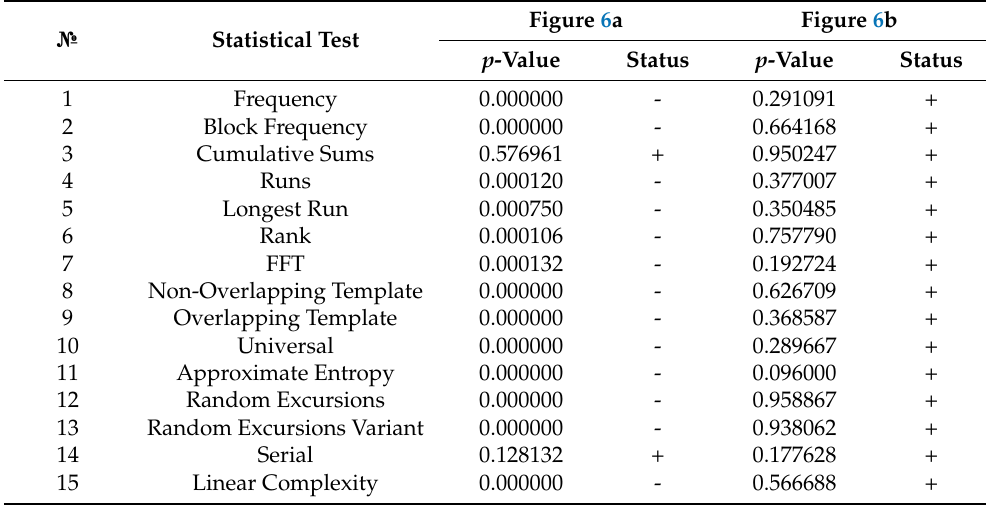
Figure 6. Statistical portrait of the MAFG output sequence: ( a ) with an odd value h = 9, ( b ) at an even value h = 10. Table 2. Results of testing MAFG by NIST.